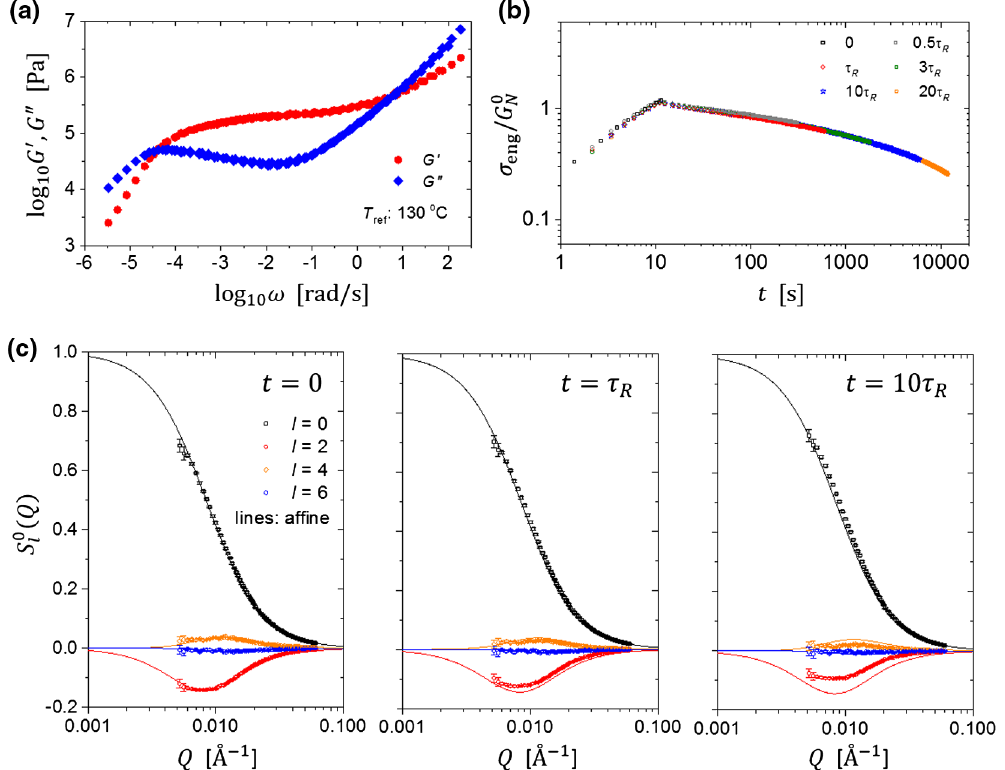
FIG. 4. (a) Linear viscoelastic properties of the mixture of d -PS and h -PS at 130 °C. (b) Stress relaxation behavior after a step deformation of λ ¼ 1 . 8 , performed with a constant crosshead velocity v ¼ 40 l 0 = τ 10 τ . The solid lines are computed according to the affine deformation model for λ ¼ 1 . 8 . The SANS data are collected on the NGB30 R SANS beam line at